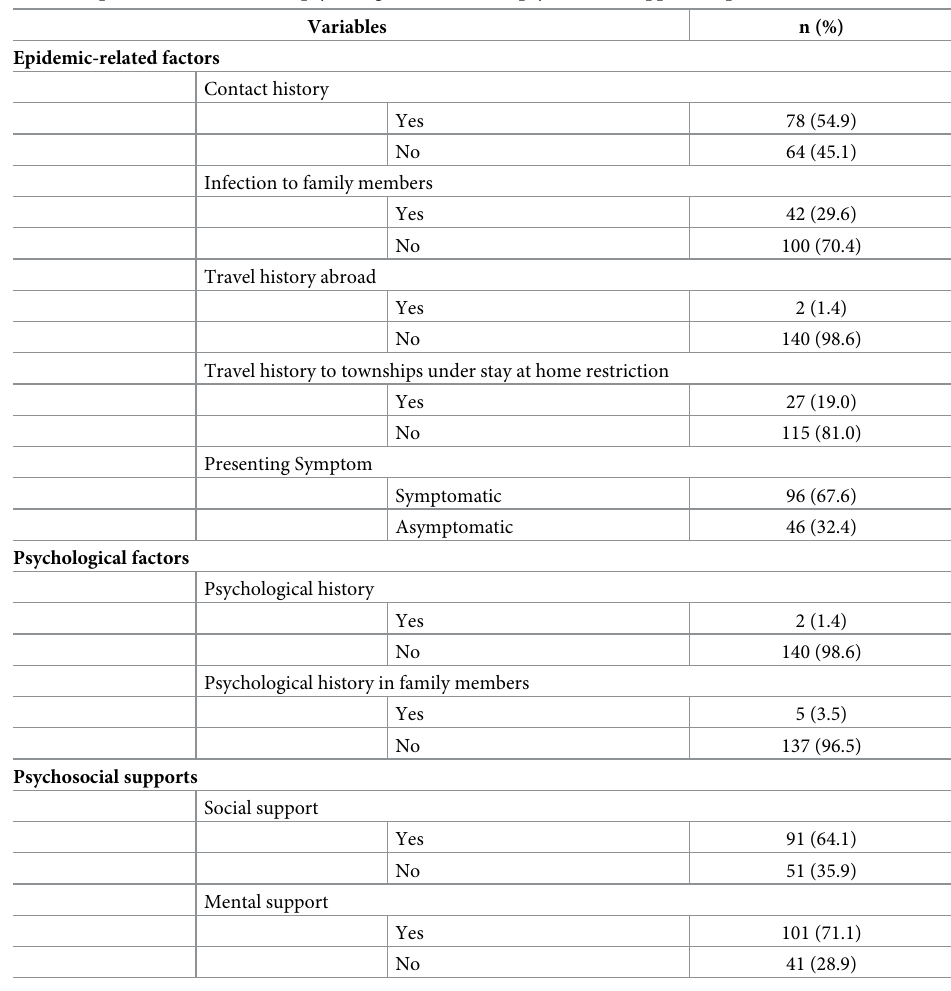
Table 2. Epidemic-related factors, psychological factors, and psychosocial supports of patients with COVID-19.